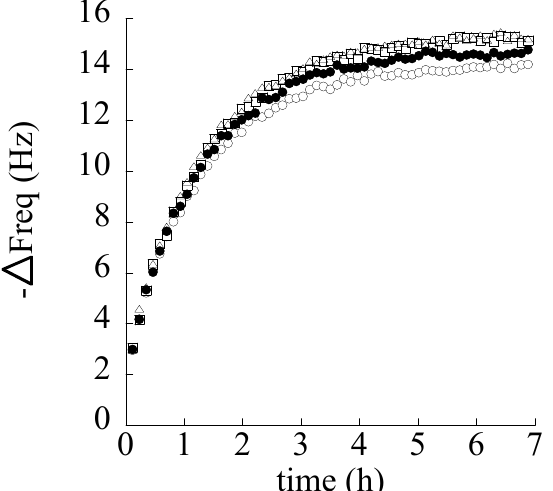
Figure 12. Repeatability tests for the 0–5 ppm step change in chloroform